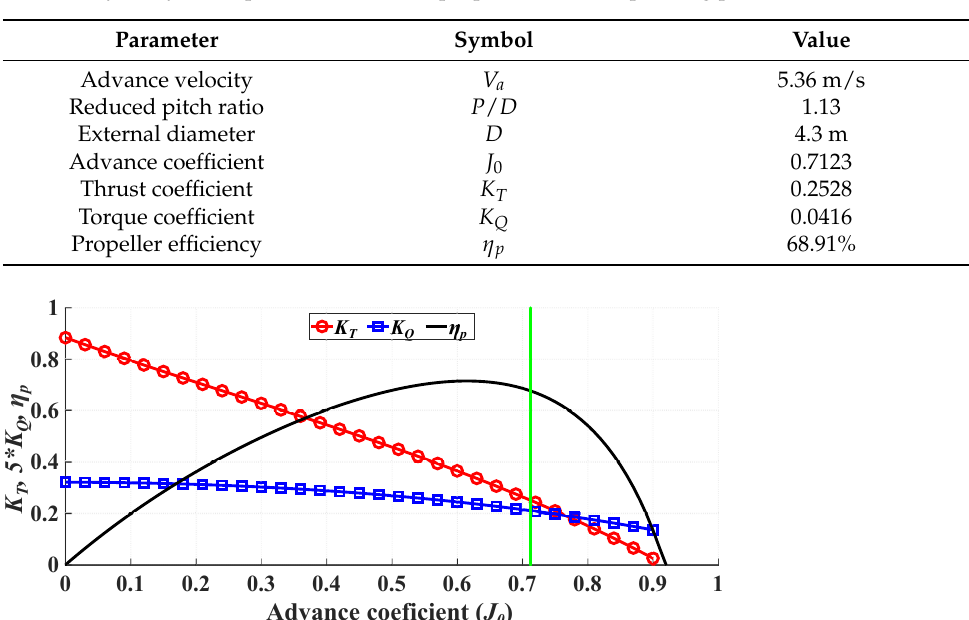
Table 4. Hydrodynamic performance of the propeller at rated operating point.